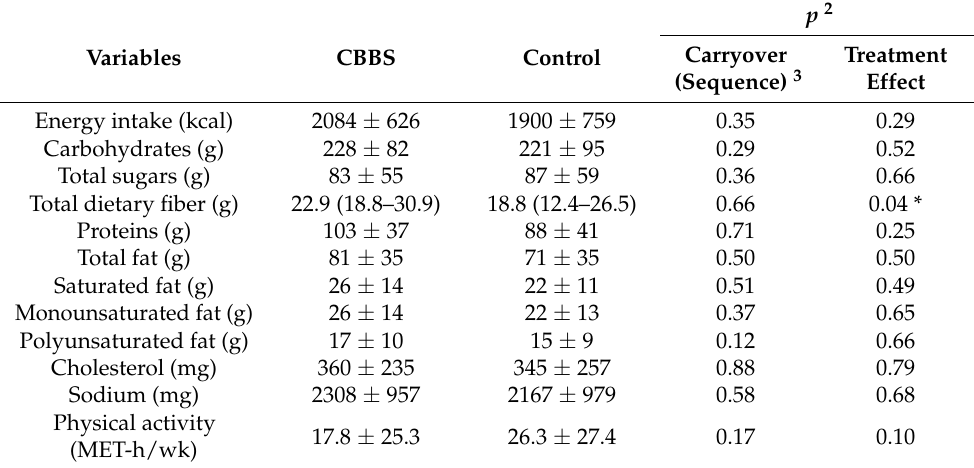
Table 3. Dietary intake and physical activity in the CBBS group and the control group 1 .